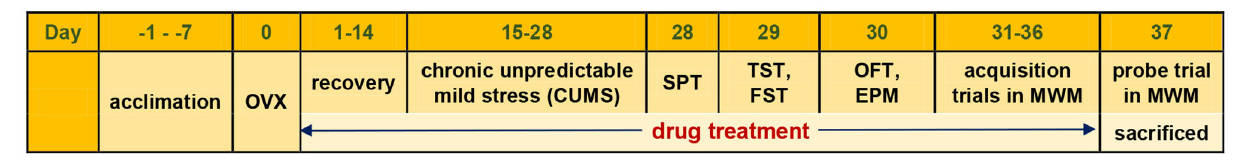
cylinder for 6 min and its movement was recorded on